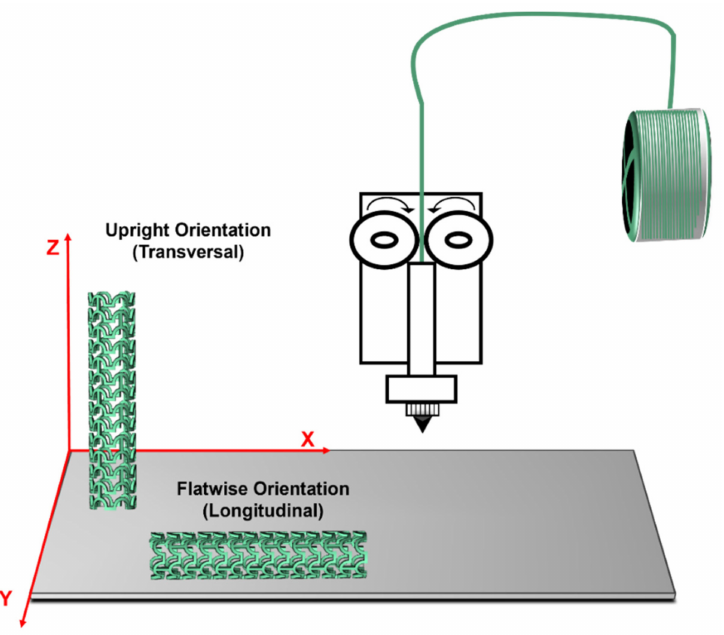
Figure 14. Schematic representation of the building orientation of 3D-printed vascular